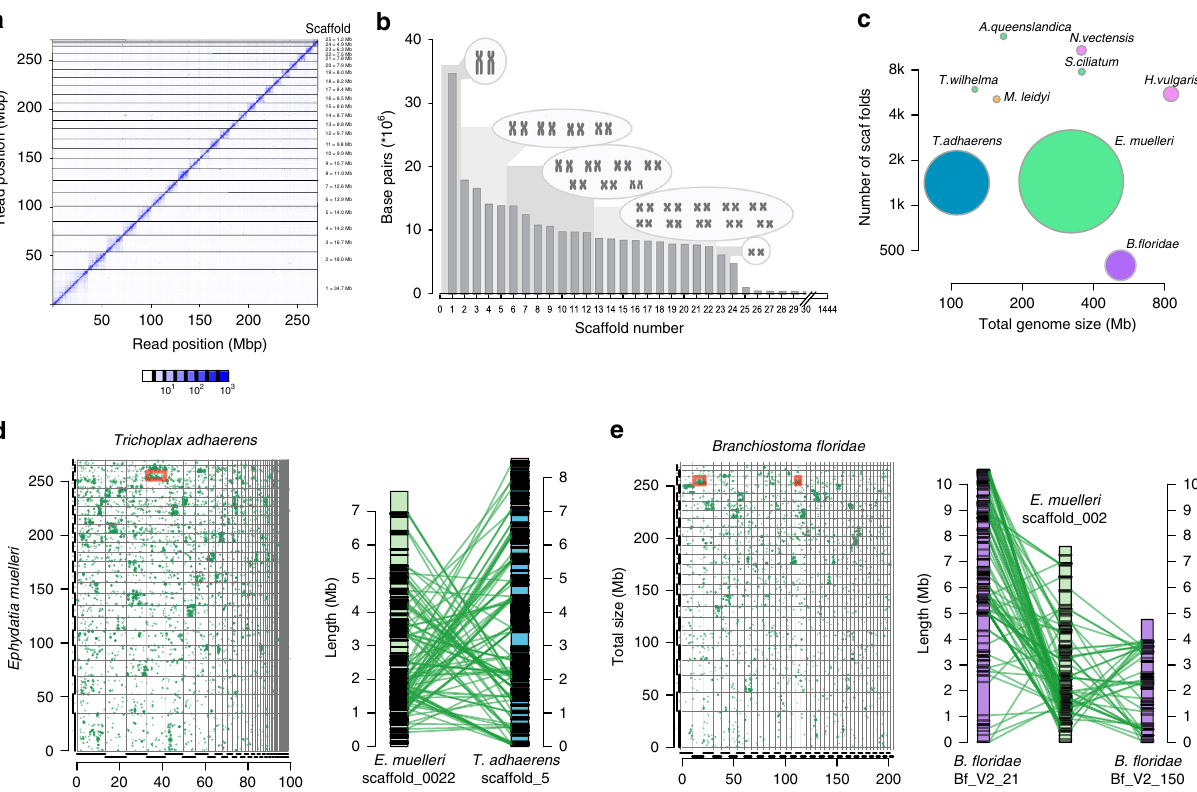
Fig. 2 Genome assembly and architecture. a Hi-C contact map, visualised in Juicebox.js, with number of contacts coloured in blue according to the scale below. b Histogram of assembly scaffold sizes and corresponding chromosomes drawn to scale after Ishijima et al. 29 Note the large difference in size between chromosome 1 and the additional 22 chromosomes, which was re fl ected in our assembly. c Representation of the relative completeness of the E. muelleri assembly compared to those of a number of commonly used genomes. N50 is represented by diameter of circles and number of scaffolds / genome size are on the x and y axes, respectively. The high level of contiguity of our assembly is obvious in this comparison. d Conserved syntenic signal in Ephydatia muelleri with Trichoplax adhaerens , e and with Branchiostoma fl oridae . Each small green dot on the matrices represents an identi fi ed homologous gene pair. Individual scaffolds for each species pair possess numerous homologous genes. Red-boxed locations are shown in detail to the right of each matrix as chromosomal representations. Each black line on the chromosome images represents a gene linked in green to the homologous gene in the other species. It is clear that numerous genes are conserved between ancestrally homologous chromosomal regions between these species, although their relative arrangement within chromosomes is shuf fl ed, as expected under the DCJ-DS model of syntenic evolution. Source data are provided as a Source Data fi